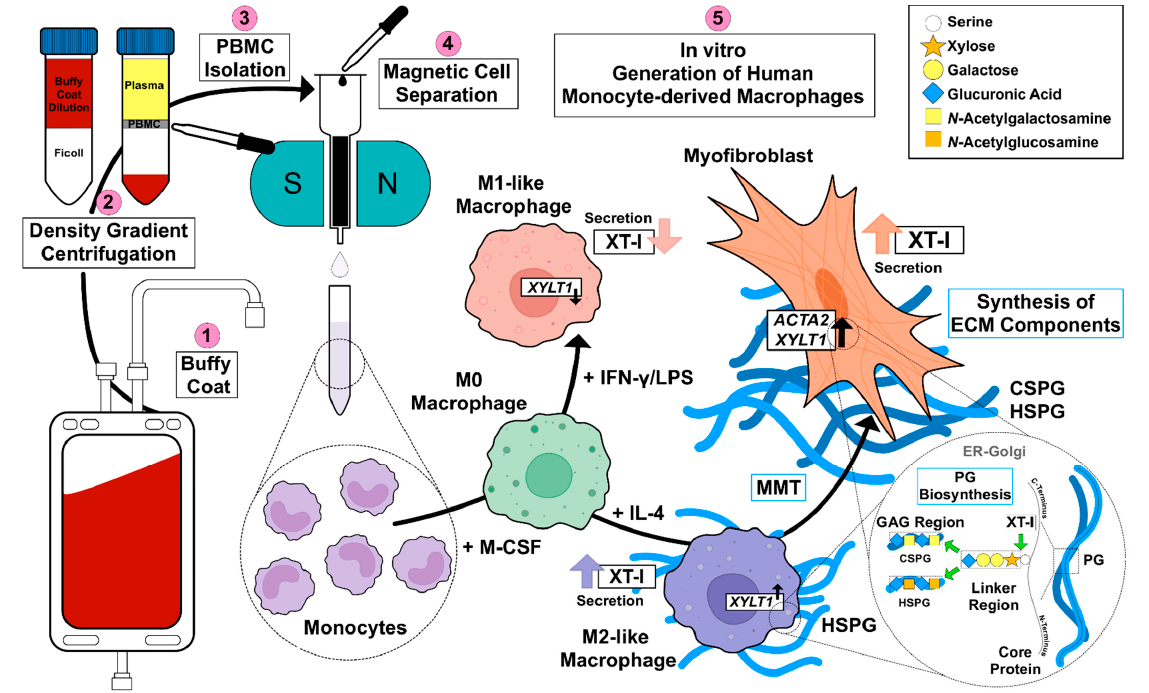
Figure 6. Schematic illustration of the main findings of this study, and the relationships between PBMC, M Φ subtypes, XT-I, PG and GAG. Since in vitro generated M-M Φ from patients with SSc have been shown to express surface markers that are associated with M1 and M2 polarization [46,47], we decided to use a simplified primary M-M Φ cell model that mimicked the M Φ subtypes found in prototypical inflammatory fibrotic disease SSc. Accordingly, PBMC from healthy blood donors were subjected to a negative selection of CD14 + and/or CD16 + monocytes. The M Φ generated were polarized in the presence of LPS/IFN- γ or IL-4 toward M1-like and M2- like M Φ subpopulations, respectively. The efficacy of M Φ polarization was confirmed by the analysis of surface markers, IL-6 cytokine secretion and the gene expression of widely accepted M Φ activation state markers. Consistently with the findings from previous